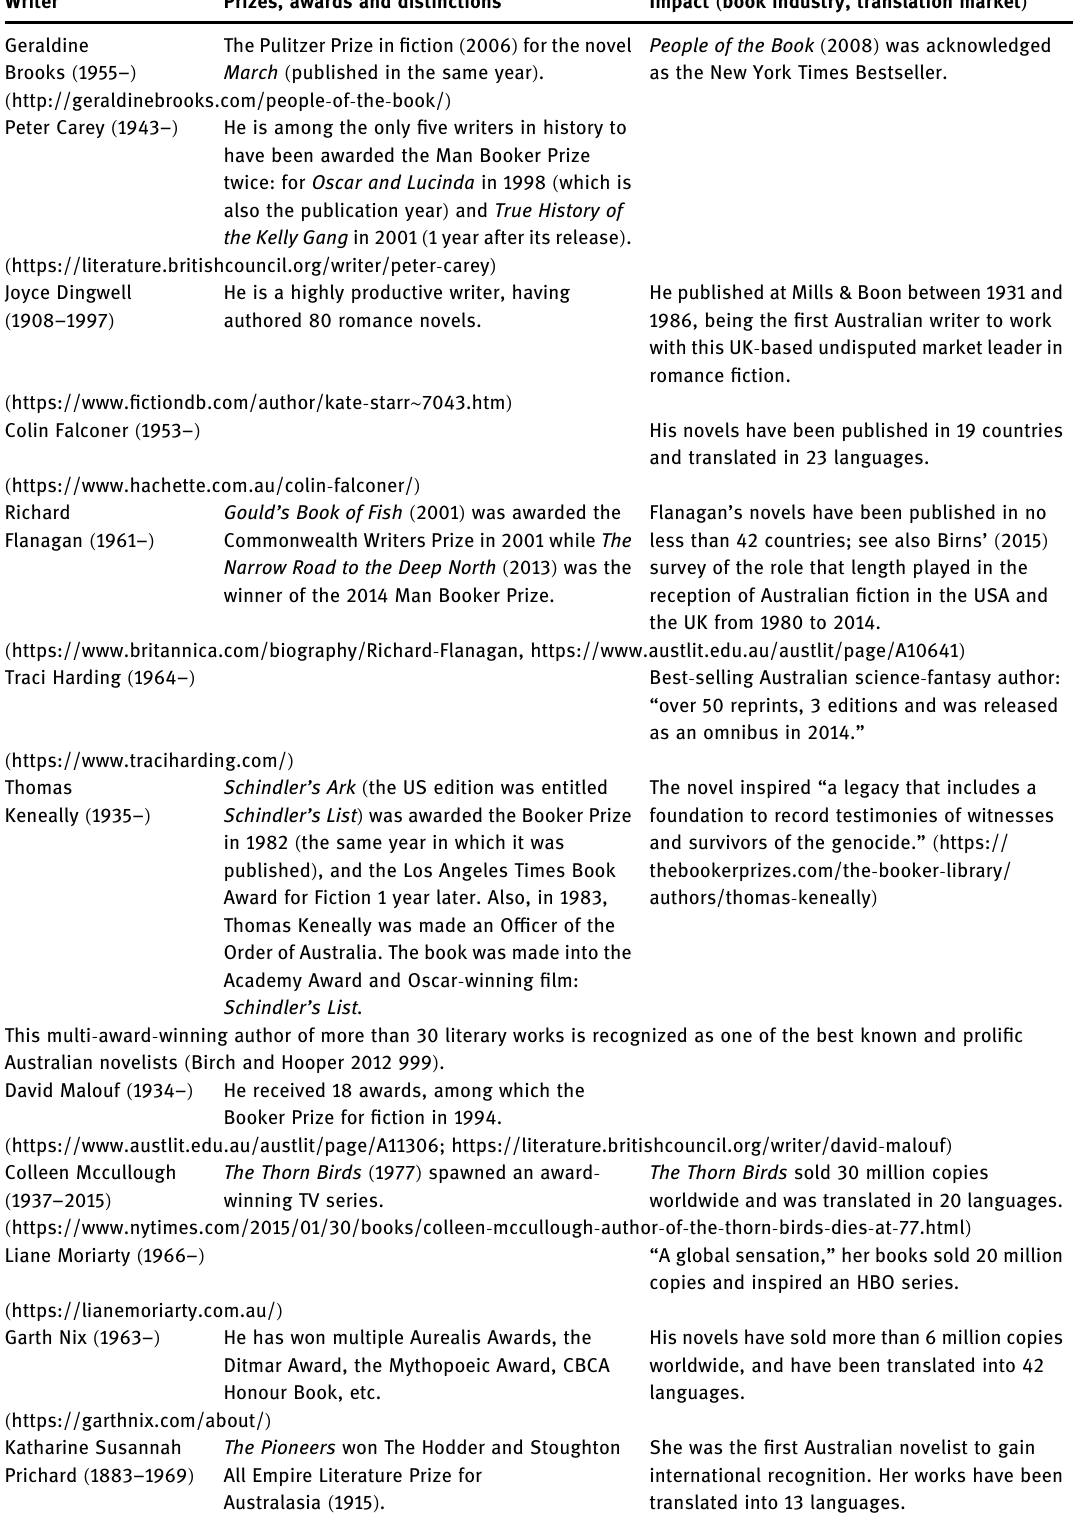
Table 4: Proofs of translated - born literature